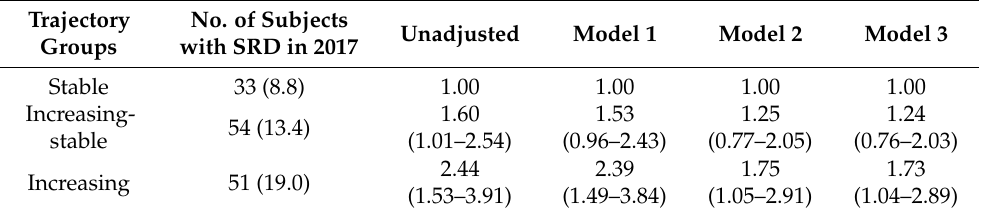
Table 3. Adjusted odds ratios and 95% confidence intervals of the association of SRD risk score trajectory groups with subclinical kidney